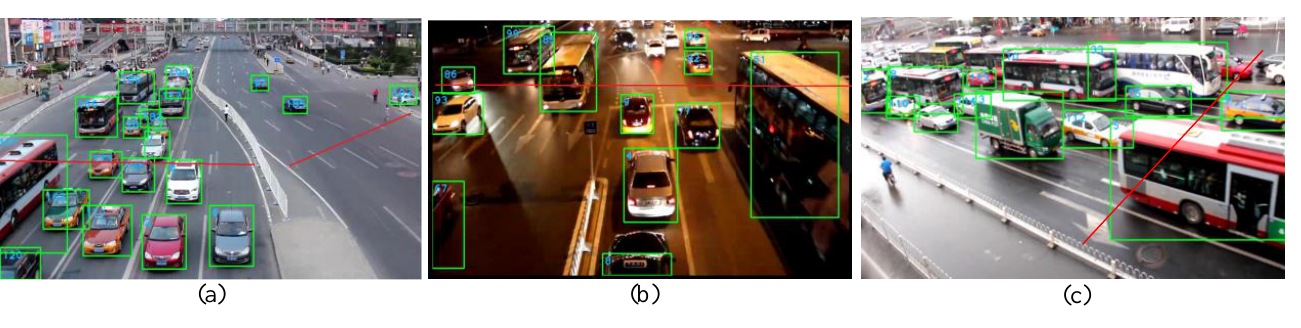
Figure 18. Tracking using RE-ID Deepsort. ( a ) Detection result of MVI_40701. ( b ) Detection result of